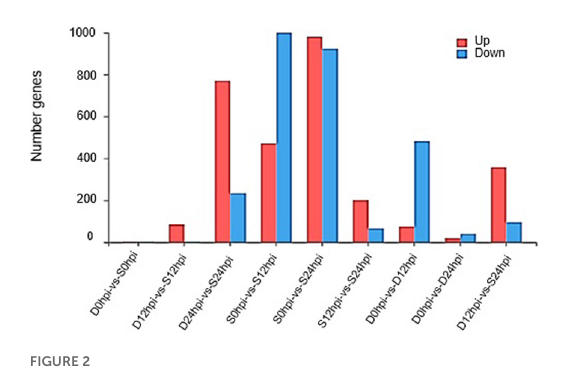
FIGURE2 Changes in gene expression profile. The DEGs numbers of up-regulated and down-regulated genes among groups S and D at different time points are